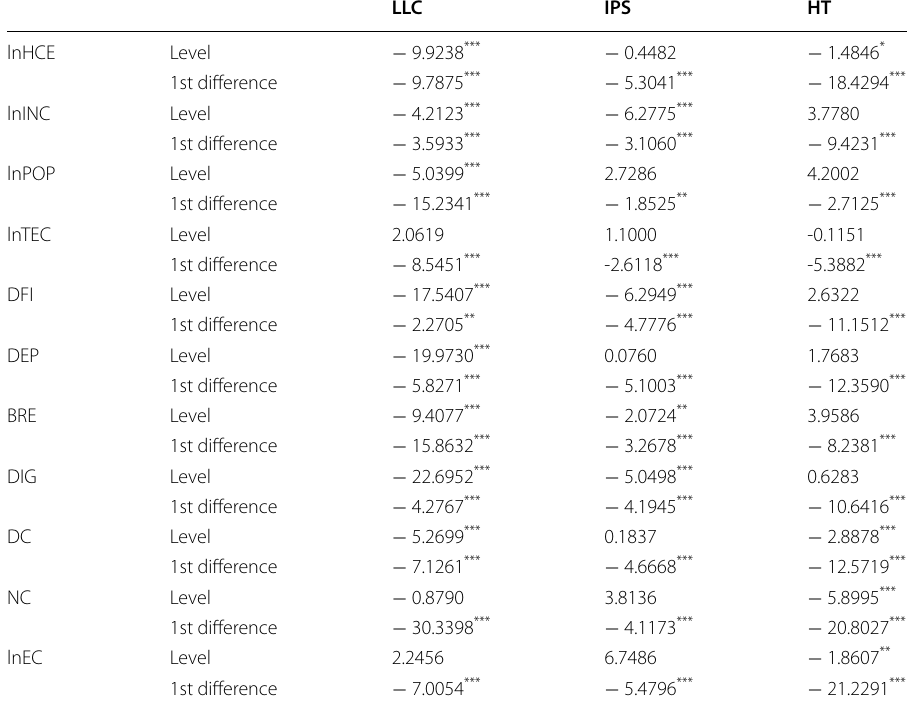
* , ** , *** imply the significance at the 10%, 5%, and 1% levels,